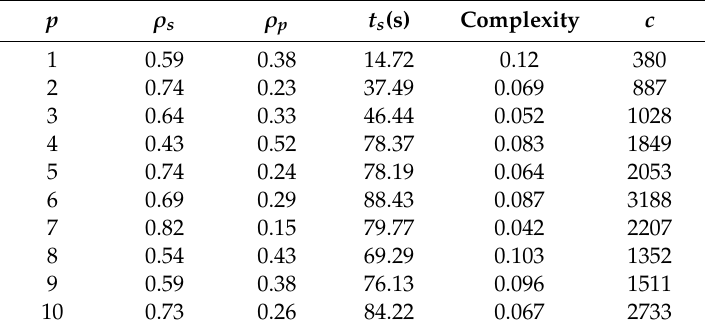
Table 4. ρ s and ρ p and